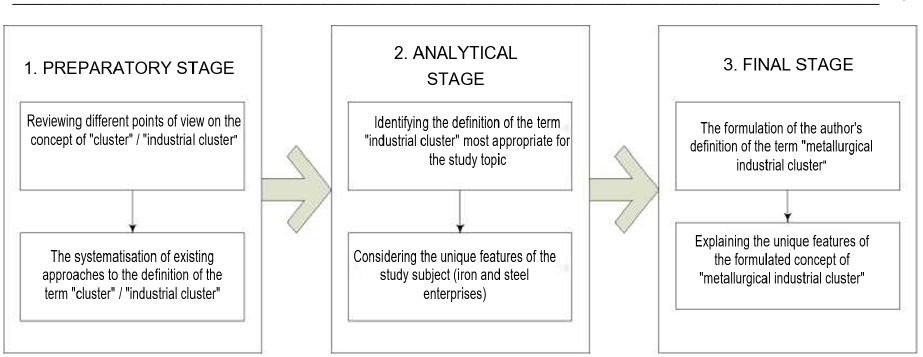
Fig. 1. The formulation stages for the author's definition of the term “metallurgical industrial